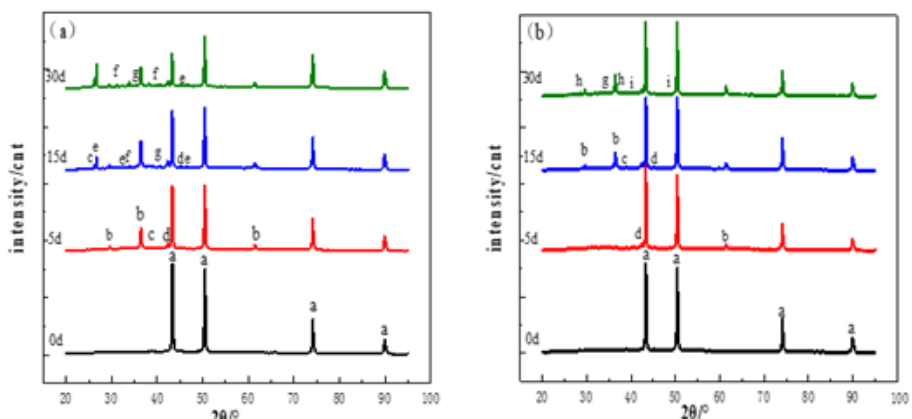
Figure 11. X-ray diffraction of copper sample in organic acid environment: ( a ) Formic acid; ( b ) Acetic